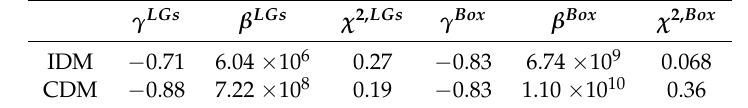
Table 2. Best-fit parameters and χ 2 values for the cumulative subhalo mass function given in Equation (8) according to our data. We show results for both IDM and CDM as obtained from our LG and Box simulations.